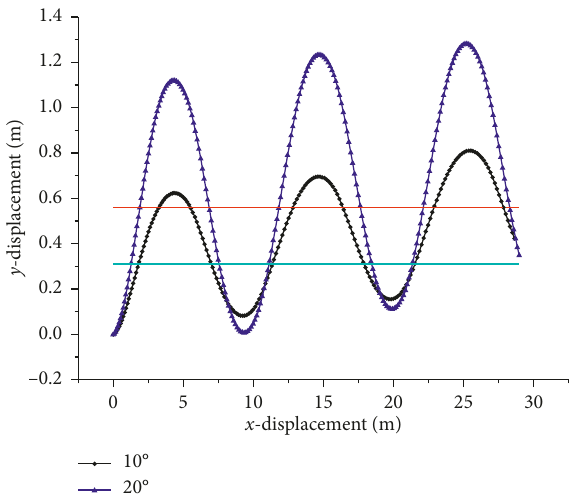
Figure 7: Comparison between Heinrich [32] and experimental free surface at 0.6s.